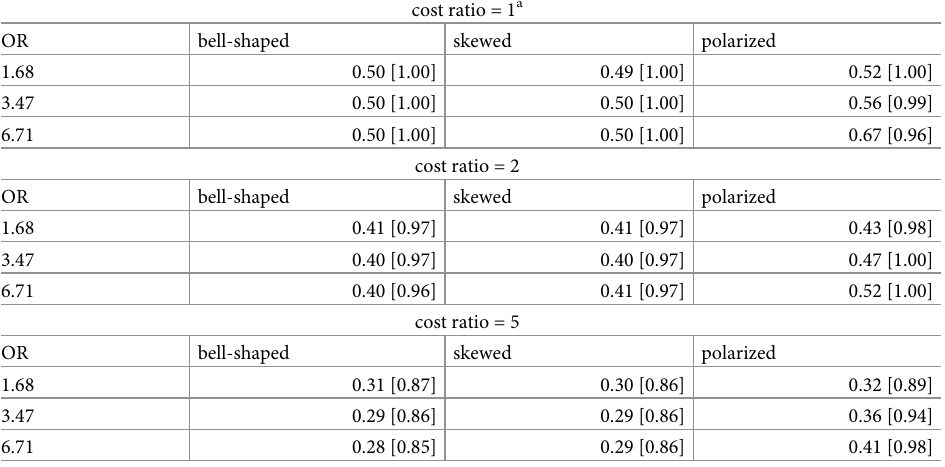
Table 1. Optimal proportion of subjects in the intervention [efficiency of the balanced design] for three response categories.